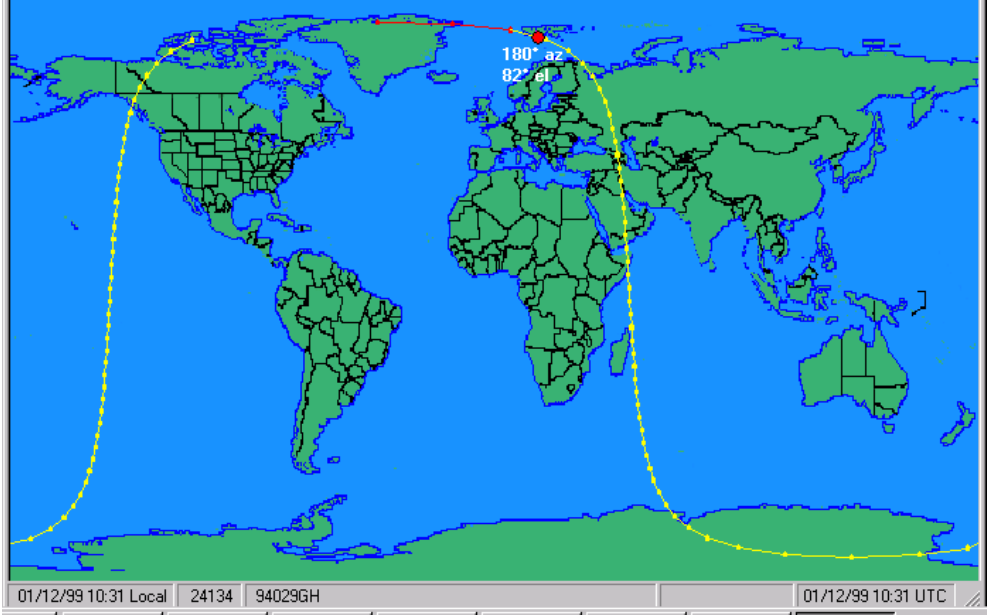
Fig. 5. Path of space debris, NORAD number 24134-94029GH, showing its position relative to the radar at ESR at 10:31:13UT on 1 December 1999. Table 1. A sample of times at which a satellite or item of space debris appeared within the ESR beam on 1 December 1999 Time (UT) NORAD Cat. No. Angle from centre Range (km) Power Ratio on 1 Dec 1999 of radar beam ( ◦ )